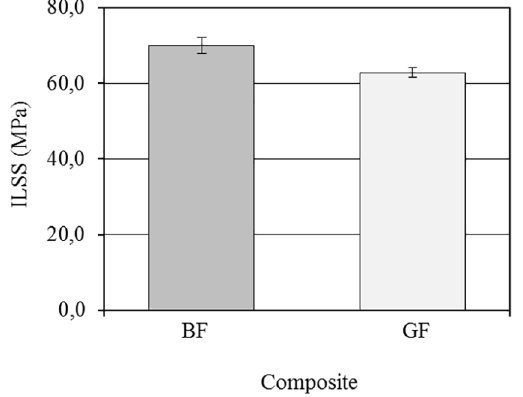
Figure 5. ILSS of BF and GF composites.